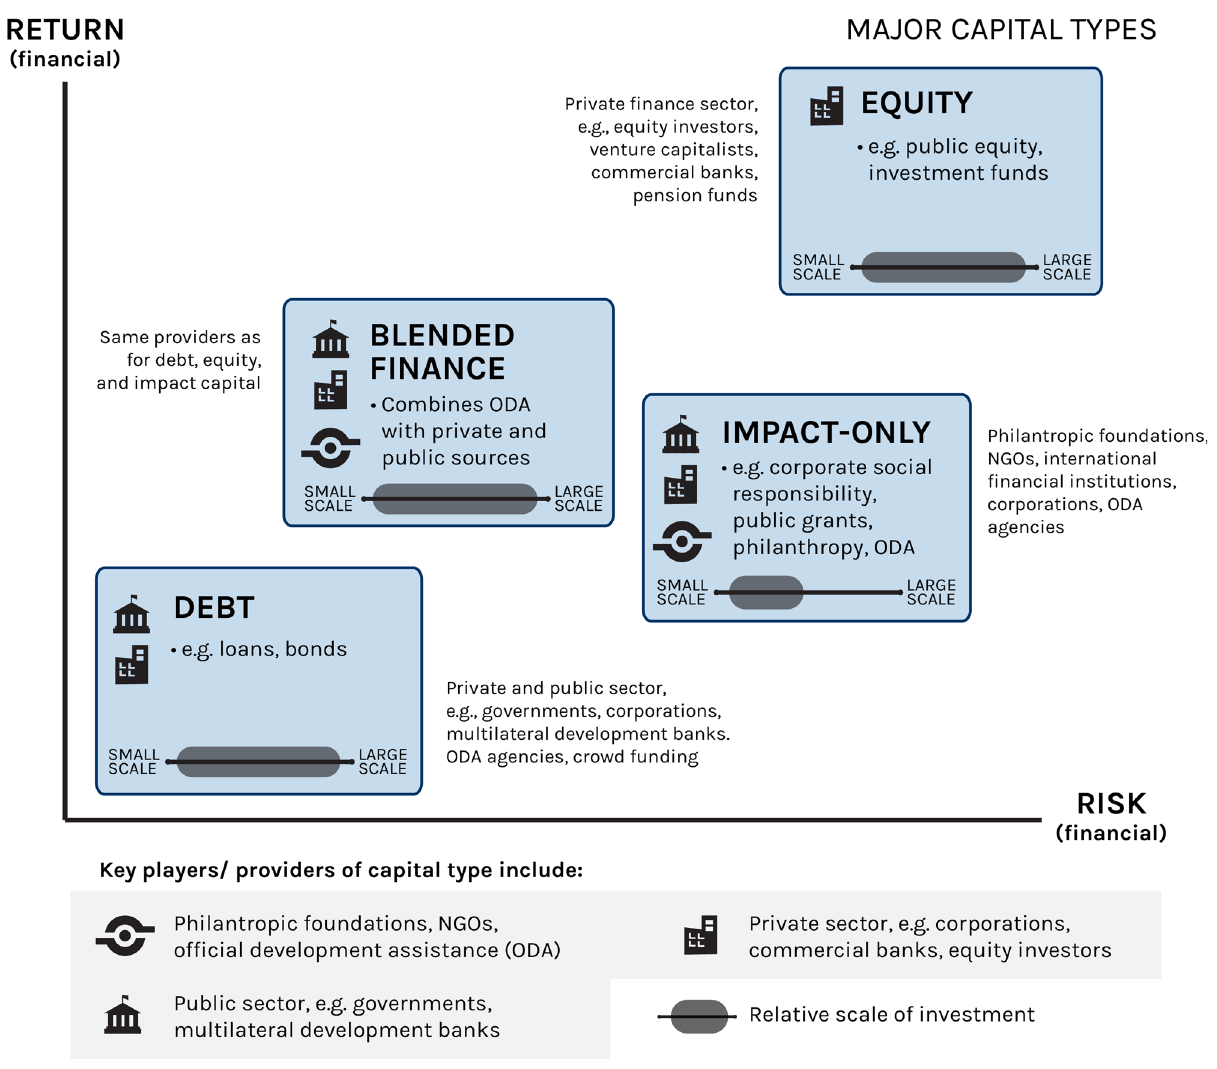
Fig. 1 Characterization of major ocean fi nance capital types. Summary of major capital types, the level of risk vs. return for each capital type, and the key providers of these capital 14